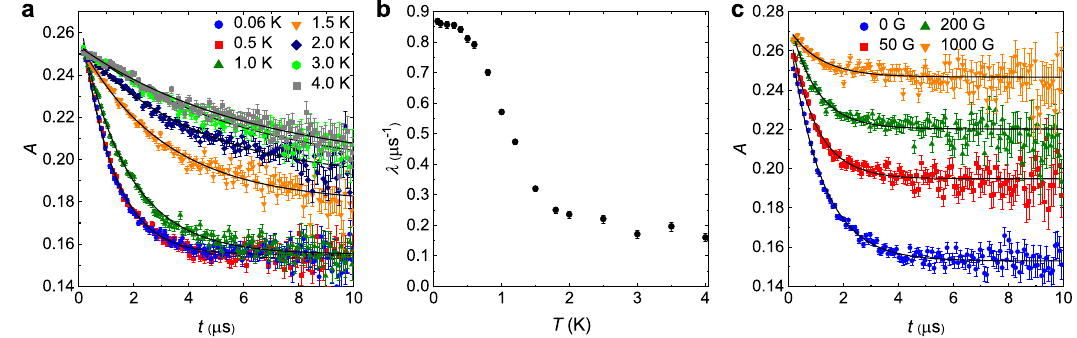
Fig. 4 Muon spin rotation and relaxation ( μ SR). a Zero- fi eld μ SR of Ba 2 LuMoO 6 at different temperatures. Magnetism in Ba 2 LuMoO 6 remains dynamic down to 60 mK as no magnetic transitions or spin freezing are observed. Muon spin relaxation of the sample can be described with a simple exponential Ae - λ t . b Muon spin rotation and relaxation rate λ as a function of temperature. Upon cooling below 1.5 K, λ starts to rapidly increase. This shows that the internal dynamic magnetic fi elds slow down. Below 300 mK the relaxation rate stays constant, which indicates that the ground state is dynamic. c Longitudinal- fi eld muon spin rotation and relaxation of Ba 2 LuMoO 6 at 100 mK. Decoupling the muon spins from the internal magnetic fi elds required a fi eld of over 1000 G, con fi rming that they are related to electronic and not nuclear spins. Error bars in a and c represent one standard deviation, whereas the error bars in b represent standard